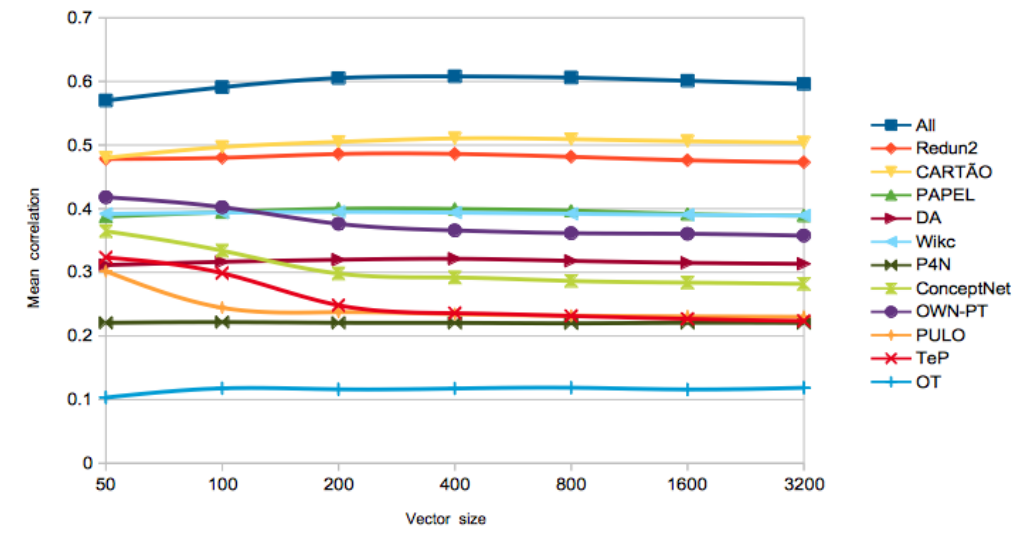
Figure 1. Evolution of ¯ ρ in SimLex-999, for different LKBs, using only synonymy and hypernymy relations, with growing vector sizes in PageRank.